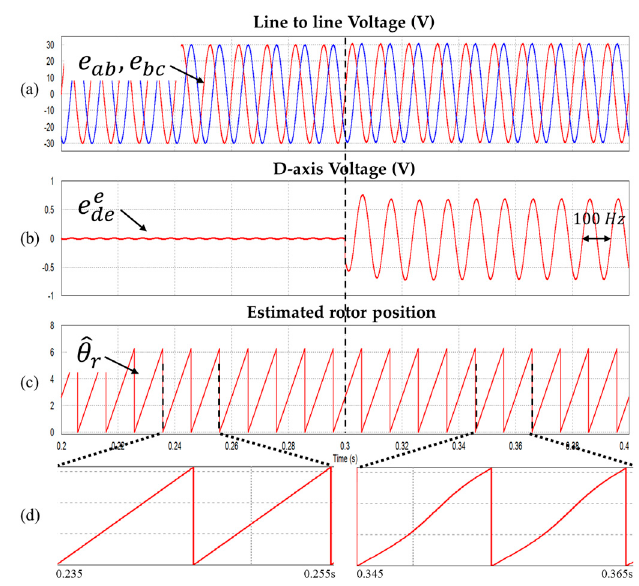
Figure 7. Waveform during injecting the 0.6 V DC offset ( a ) Line to line voltages e ab , e bc ( b ) Synchronous